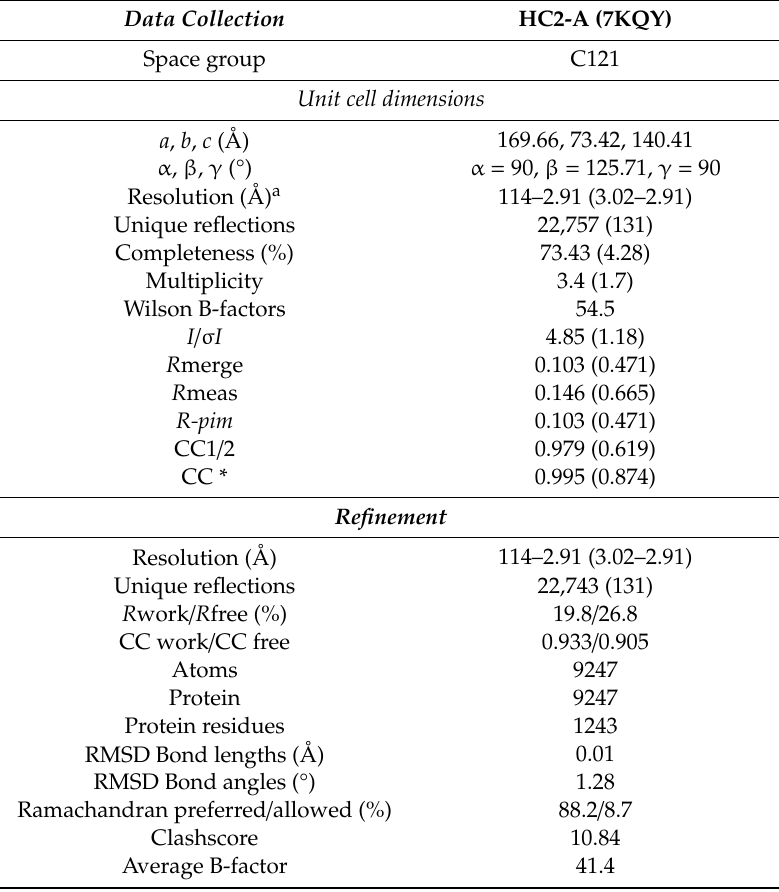
Table 5. Crystal data collection and refinement statistics. Values in parenthesis describe the highest resolution shell. Ramachandran refers to backbone dihedral